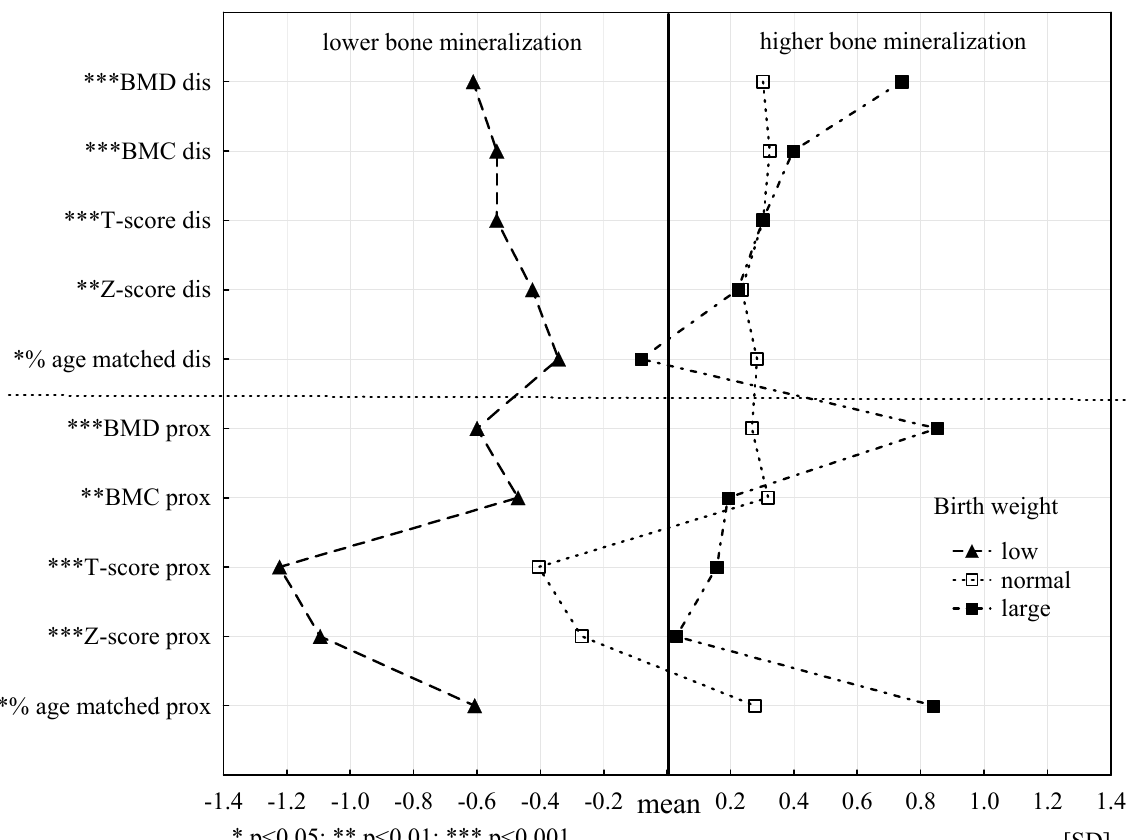
Figure 3. Biological profiles of the bone tissue mineralization status in three categories of birth weight.